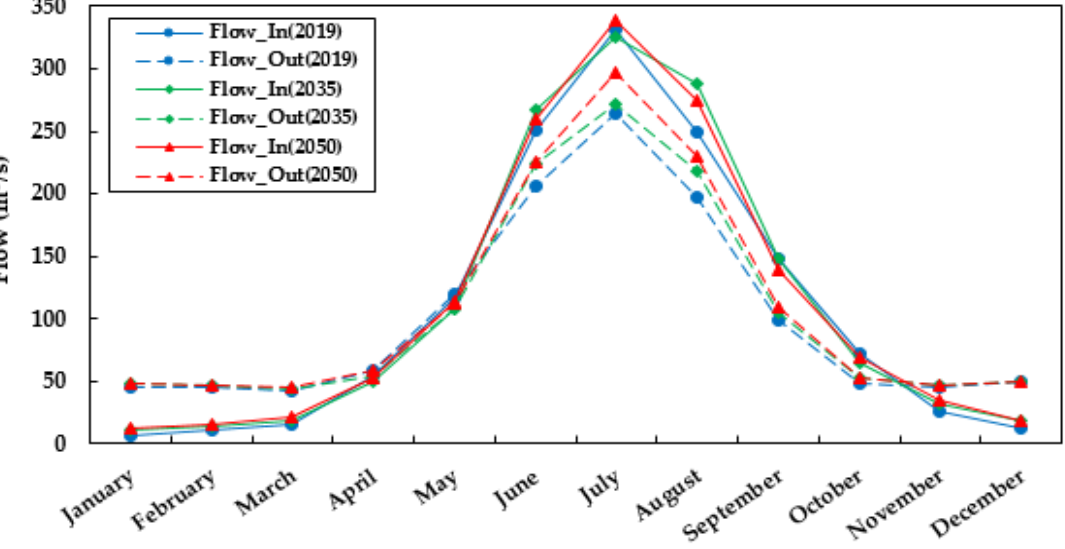
Figure 10. Average monthly reservoir inflow and optimized outflow under LULC changes.